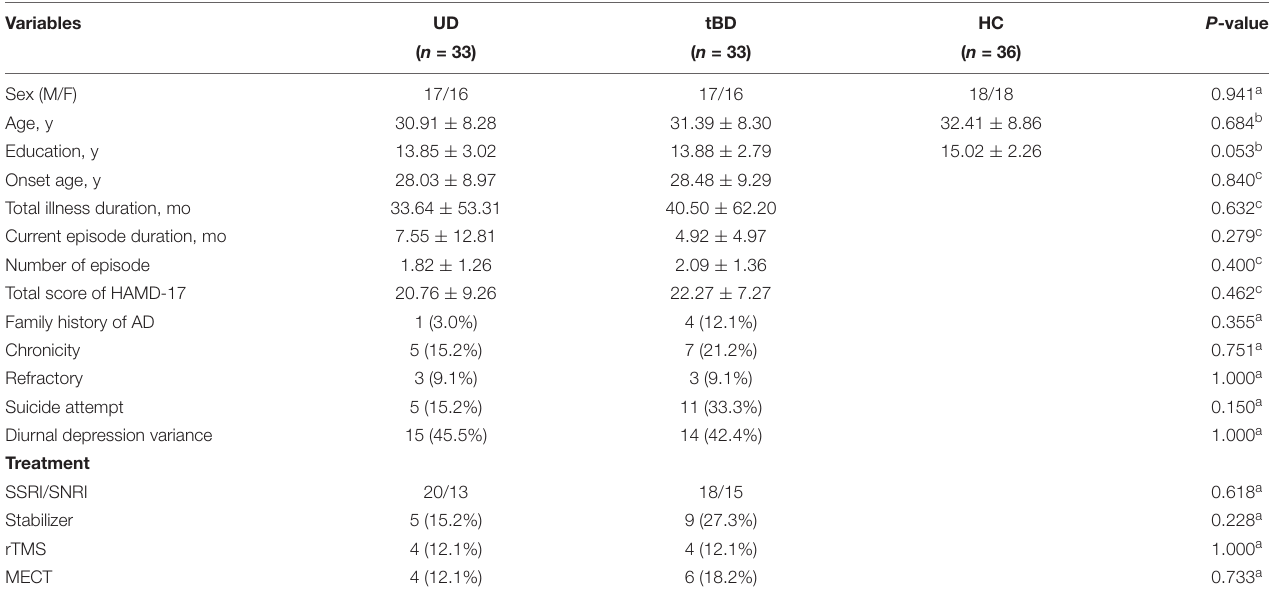
TABLE 1 | Demographic and clinical characteristics among three